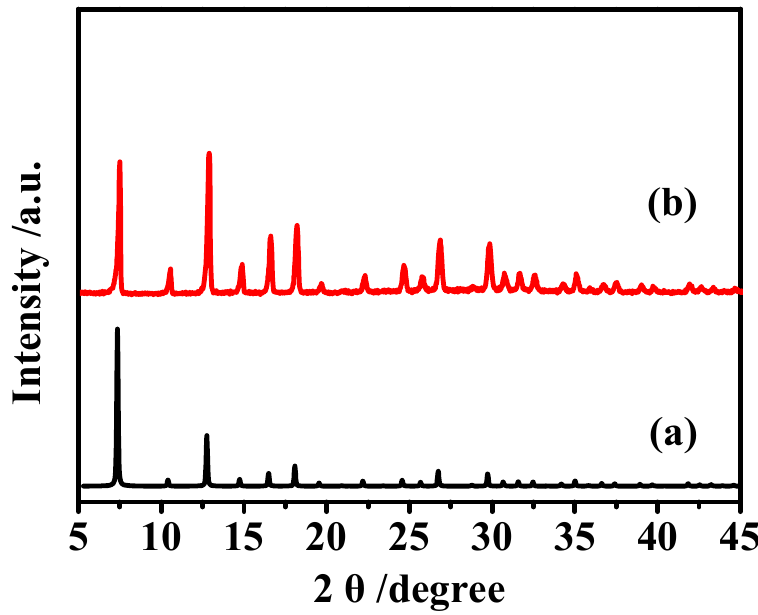
Figure 2. XRD patterns of ( a ) simulated MAF ‐ 7 and ( b ) synthesized MAF ‐ 7.